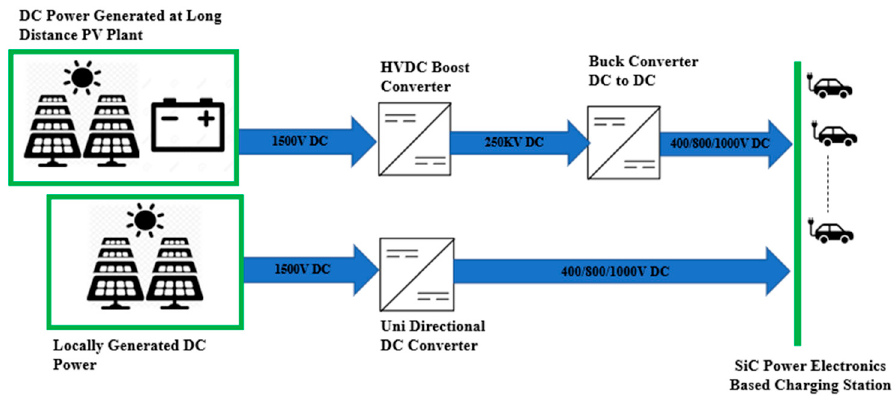
Figure 13. Fully Renewable and DC XFC Charging Infrastructure [14].